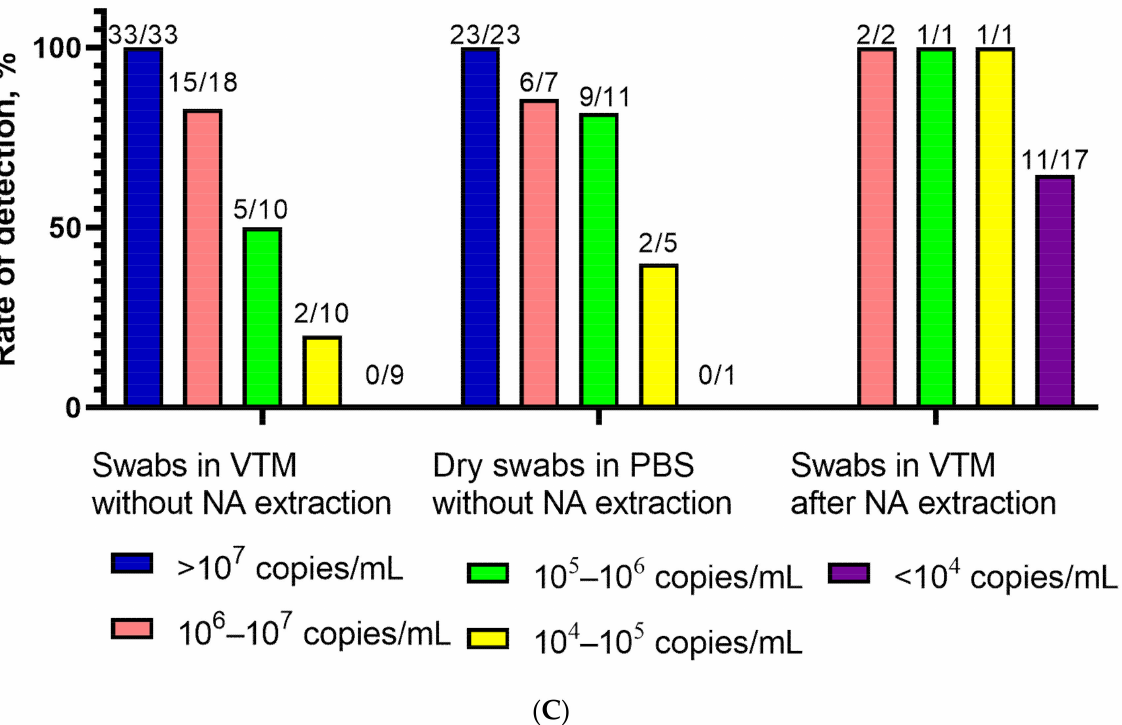
Figure 1. Inhibition rate and diagnostic performance of the loop-mediated isothermal amplification reaction (LAMP) assay. ( A ) The inhibition rate of the LAMP assay (i.e., failure in detection of rActin) was relatively high in nasopharyngeal swab samples tested without nucleic acid (NA) extraction. The numbers above the columns indicate the number of inhibited samples/number of samples tested using the LAMP assay. ( B ) The sensitivity and specificity of the LAMP assay without prior NA extraction was compared to RT-PCR after NA extraction ( n = 140). Stratification was performed with the inclusion of all or a fraction of the samples according to their viral load in copies/mL. Inhibited samples were excluded. The sensitivity of the LAMP assay increased with increasing viral load. The specificity amounted to 100% irrespective of stratification. The error bars show the 95% confidence intervals. The numbers under the lines indicate the number of samples that tested positive using the LAMP assay/number of samples that tested positive using RT-PCR, n = number of negative and positive samples above the respective viral load threshold per RT-PCR. ( C ) The rate of detection differed amongst the three groups of samples. Dry swabs without NA extraction outperformed swabs in viral transport medium (VTM) without NA extraction. Performing NA extraction prior to testing increased the detection rate for samples with low viral loads considerably. The numbers above the columns indicate the number of samples that tested positive using the LAMP assay/number of samples that tested positive using